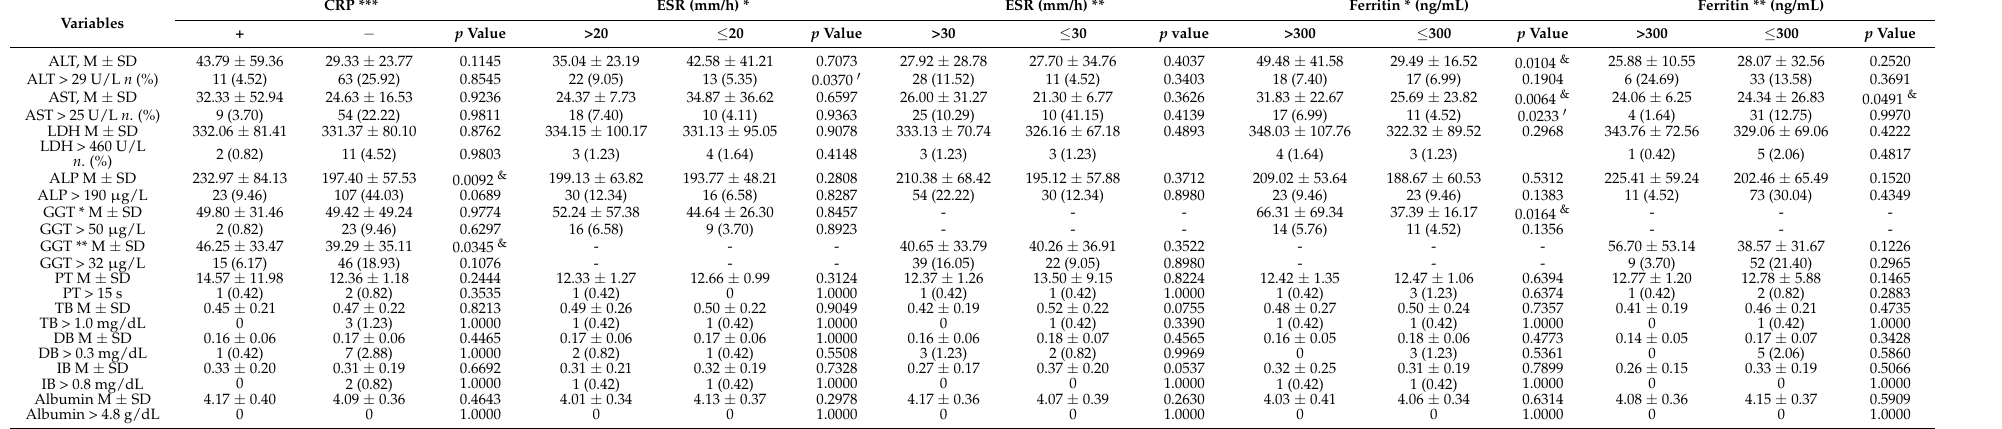
Table 3. Comparison of the laboratory variables of liver function status between groups by inflammatory markers. Bel é m/PA,